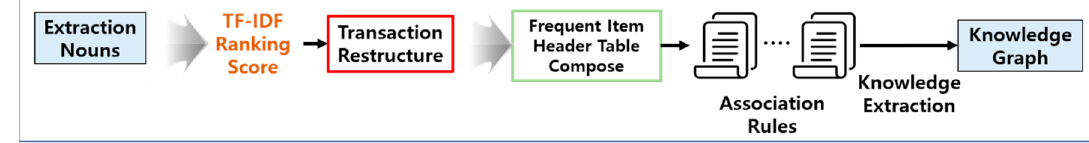
Figure 4. Optimizing process of association graph using TF-IDF ranking score.